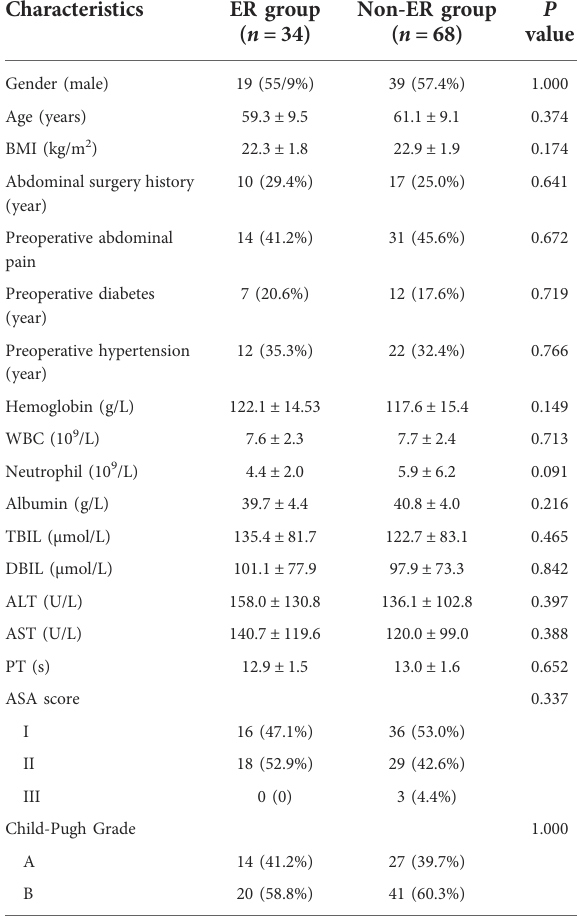
TABLE 1 Patients characteristics. Clinical characteristics between two groups were compared including the following risk factors: gender, age, body mass index (BMI), Abdominal surgery history, preoperative abdominal pain, preoperative diabetes and hypertension, American Association of Anaesthesiologists (ASA) score, and Child-Pugh score as well as measurements of white blood cells (WBC), neutrophils, haemoglobin, albumin, total bilirubin (TB), direct bilirubin (DB), alanine aminotransferase (ALT), and aspartate aminotransferase